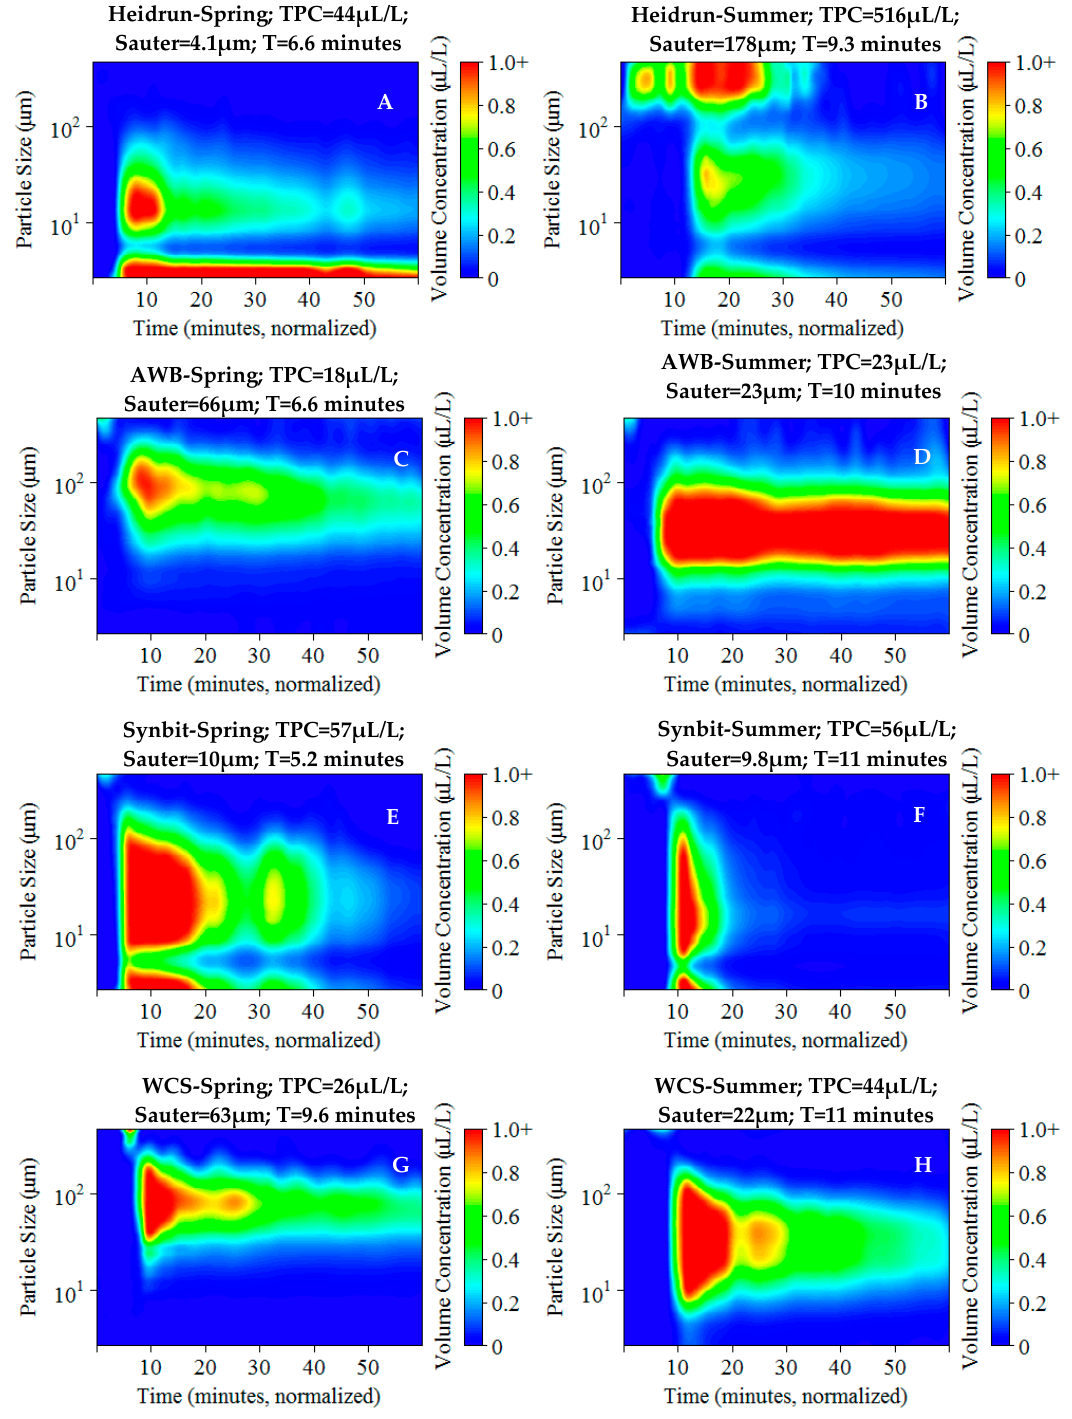
Figure 3. Contour plots (data from LISST, 12 m from oil release) illustrating seasonal effects on the concentration of oil particle size for chemically enhanced dispersion of: ( A ) Heidrun-spring, ( B ) Heidrun-Summer, ( C ) AWB-Spring, ( D ) AWB-Summer, ( E ) Synbit-Spring, ( F ) Synbit-Summer, ( G ) WCS-Spring, and ( H ) WCS-summer. The Sauter mean diameter values varied between 4 to 170 µm and high concentration of small particles (<100 µm) were detected in all cases.